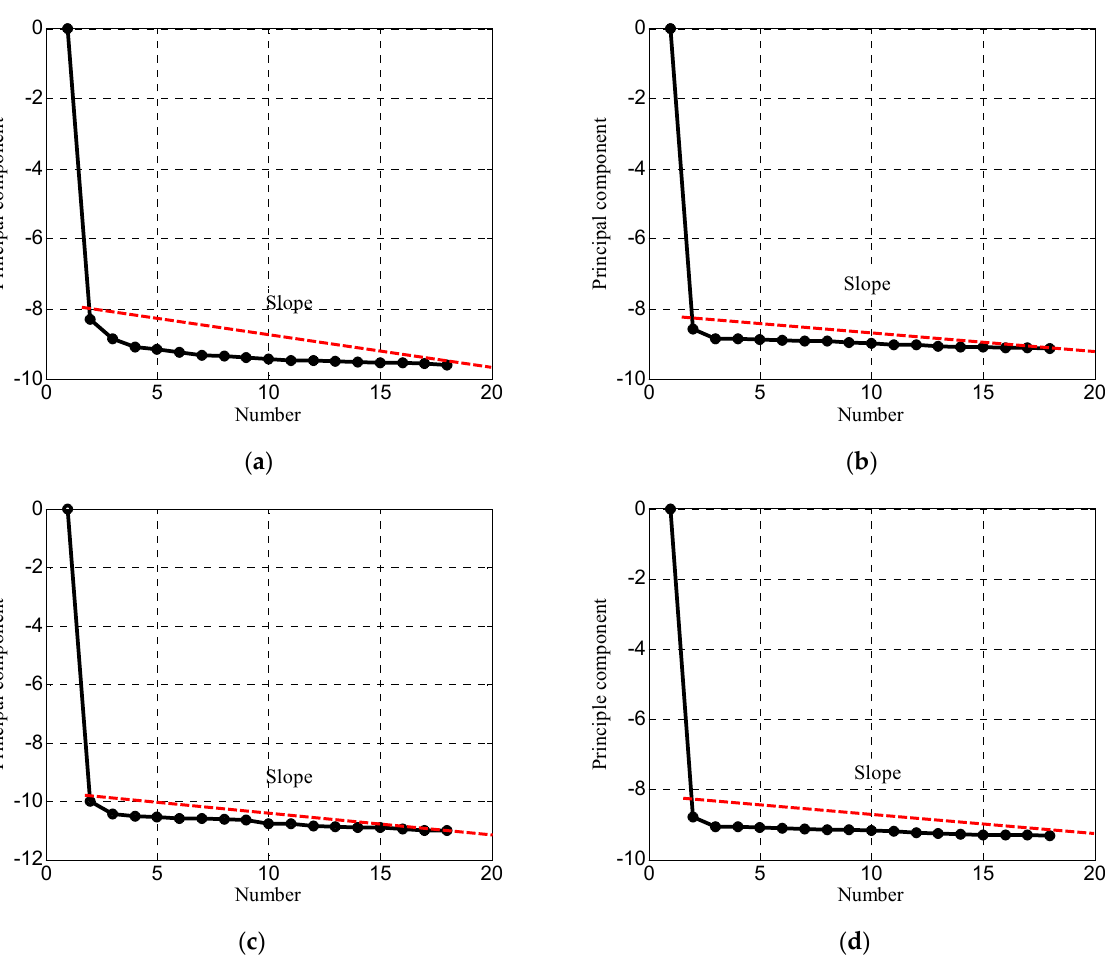
Figure 5. PCA of autonomous EDM process and the tendency of projections of associated state vectors onto the principal axes of inertia of such mass distribution. ( a ) Unstable spark discharge; ( b ) stable spark discharge; ( c ) stable arc discharge; ( d ) transient arc discharge.